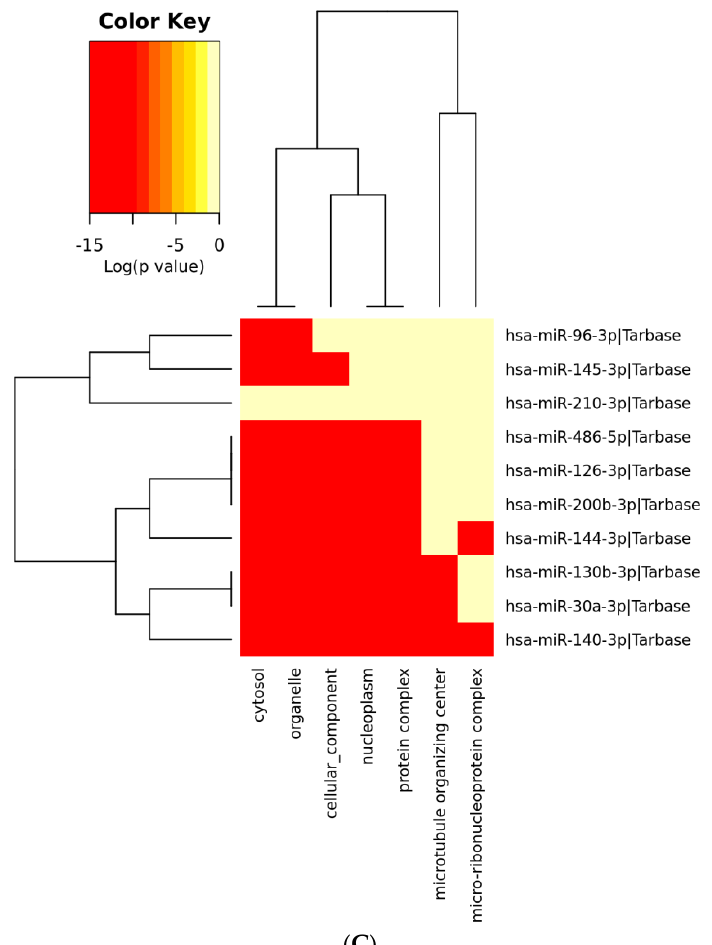
Figure 6. Gene Ontology of the 10 candidate sepsis DEM biomarkers. Representation of functional enrichment of miRNAs showing ( A ) miRNAs versus Molecular Functions, ( B ) miRNAs versus Biological Processes, and ( C ) miRNAs versus Cellular components. Abbreviations: DEMs: Differentially expressed miRNAs.